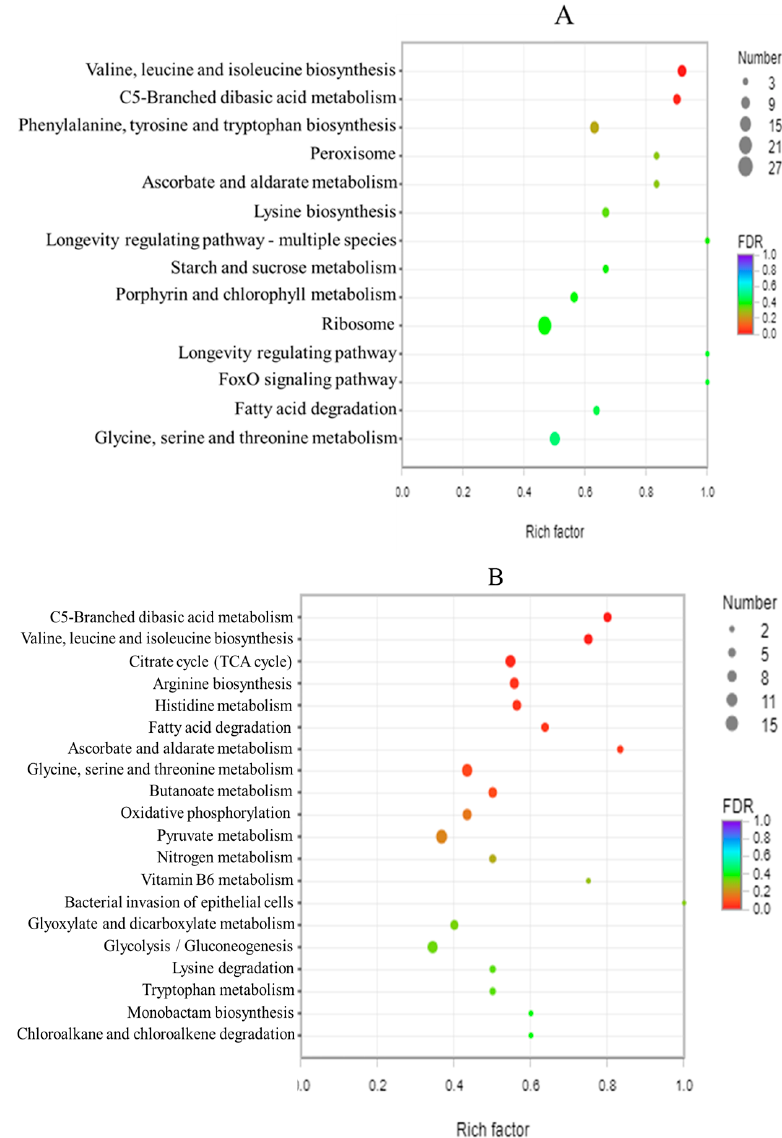
Figure 8. Scatter plots of enriched KEGG pathways for DEGs in BB-11 ( A ) and BA-26 ( B ). The vertical axis represents the name of the pathway, and the horizontal axis represents the enrichment factor. The size of the point represents the number of genes in this pathway in the gene set, and the color of the point corresponds to different ranges of FDR values.